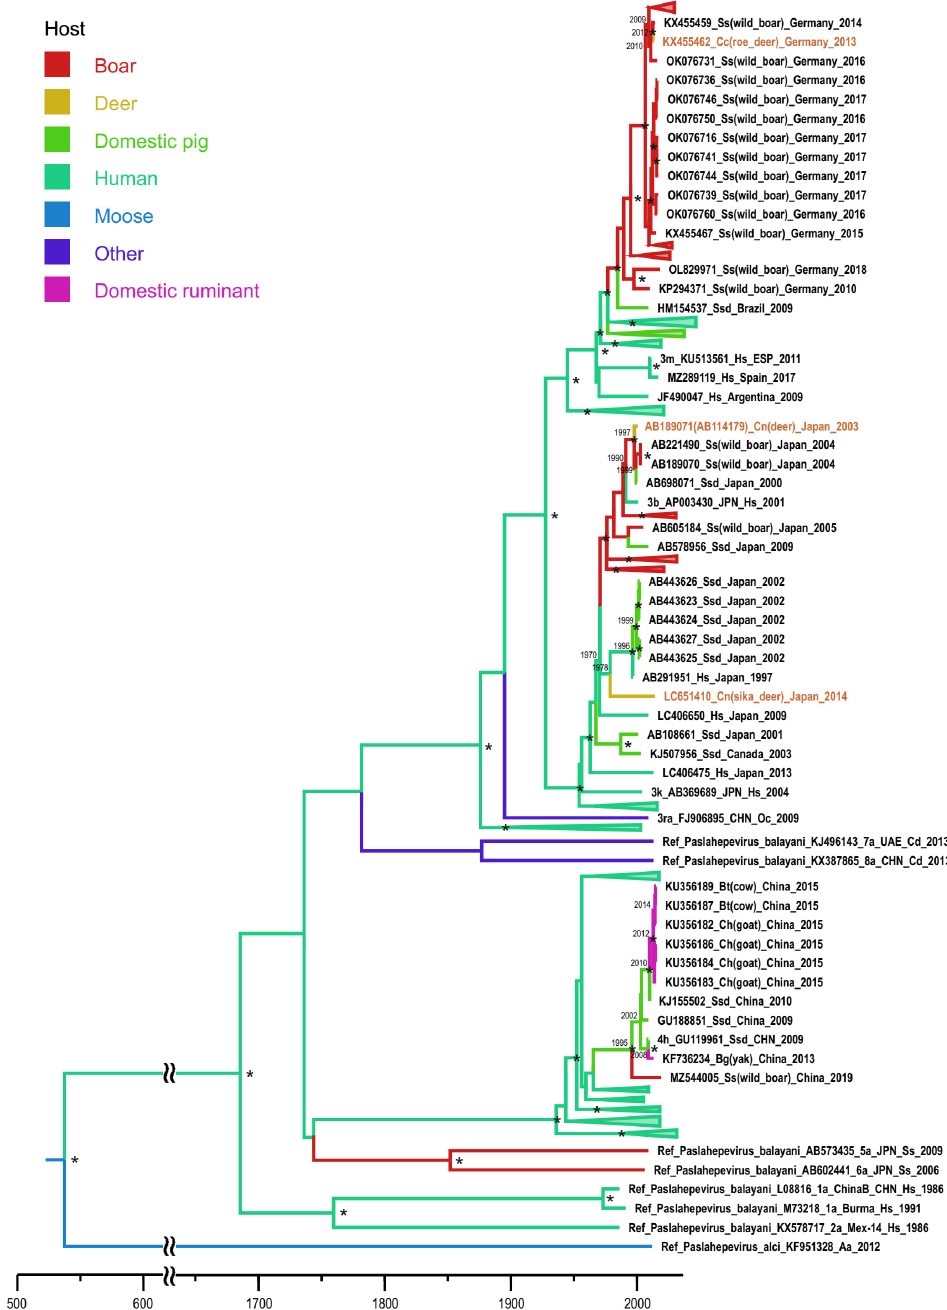
Figure 1. Bayesian phylogenetic tree based on 326 nucleotide ORF1 HEV sequences with indicated host range. The tree root was cut off to ensure the visibility of the modern parts of the tree. For each sequence, the number in the GenBank database, country (region), host organism, and the year of isolation are indicated. Host designations are as follows: Hs—human ( Homo sapiens ), Ssd—domestic pig ( Sus scrofa domesticus ), Ss—wild boar ( Sus scrofa ), Cc—Roe deer ( Capreolus capreolus ), Cn—Sika deer ( Cervus nippon ), Oc—rabbit ( Oryctolagus cuniculus ), Cd—camel ( Camelus sp.), Bt—cow ( Bos taurus ), Ch—goat ( Capra hircus ), Bg—yak ( Bos grunniens ), and Aa—moose ( Alces alces ). The sequence names from the samples collected from deer are shown in brown. Tree nodes with posterior probabilities >90% are marked “*”. For key nodes, the calculated years of formation are indicated. The X axis shows chronological time expressed in years.